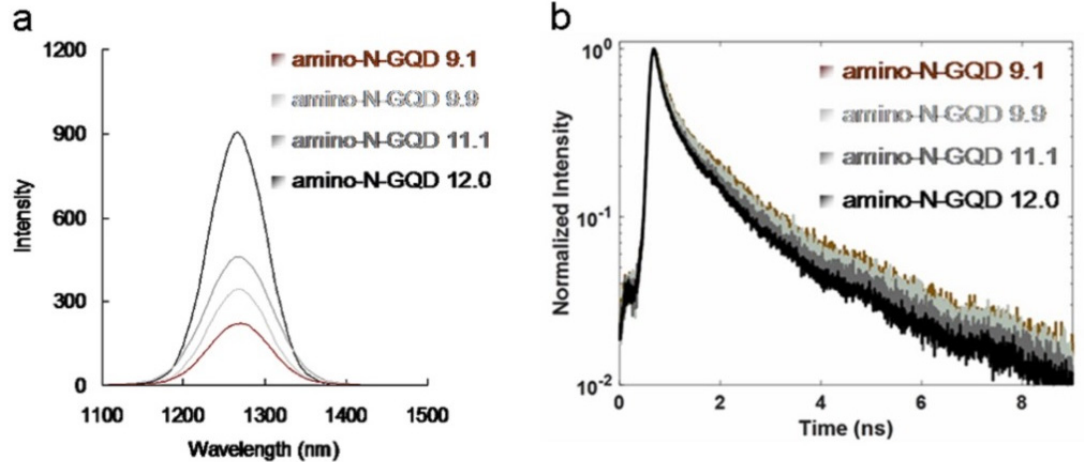
Figure 5. ( a ) Phosphorescence spectra of the sorted amino-N-GQDs (obtained at 1270 nm). ( b ) Decay profiles of the time-resolved room-temperature TPL material. Delivered dose: 0.75 μ g mL − 1 material.